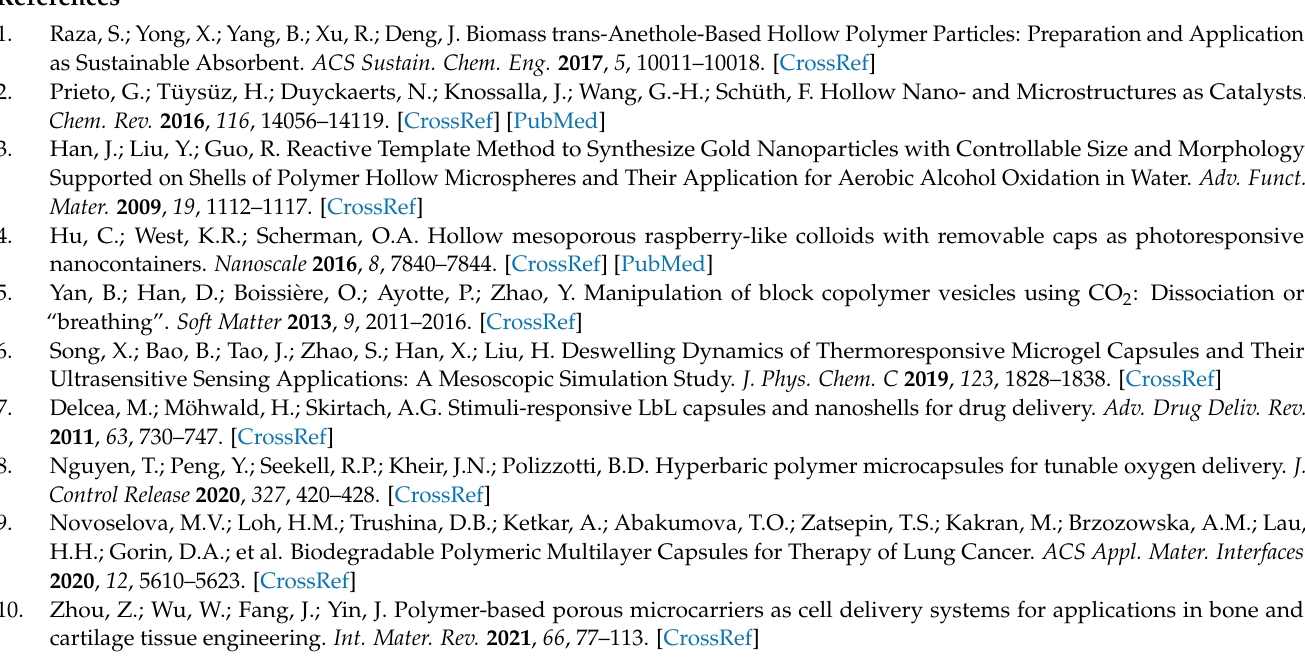
Figure S3: 1 H NMR spectrum of the amphiphilic polymers obtained by irradiating 0.01 mol L − 1 DCH18C6 aqueous solution. The inset is 1 H NMR spectrum in the range of 8.5–13.5 ppm, Figure S4: XPS spectrum of the hollow microspheres obtained by irradiating 0.01 mol L − 1 DCH18C6 aque- ous solution for 167 h, Figure S5: The SEM image ( a ) and size distribution ( b ) of the well-defined hollow microspheres obtained by irradiating 0.01 mol L − 1 tetrahydropyrane aqueous solution for 167 h, Figure S6: The size distribution of the core-shell am-DCH18C6 micelles obtained from the disassembly of the hollow microspheres obtained by irradiating 0.01 mol L − 1 DCH18C6 aqueous solution for 167 h in 1 mol L − 1 KOH aqueous solution, Figure S7: The size distribution of the hollow microspheres obtained by reassembling core-shell am-DCH18C6 after 56 h of